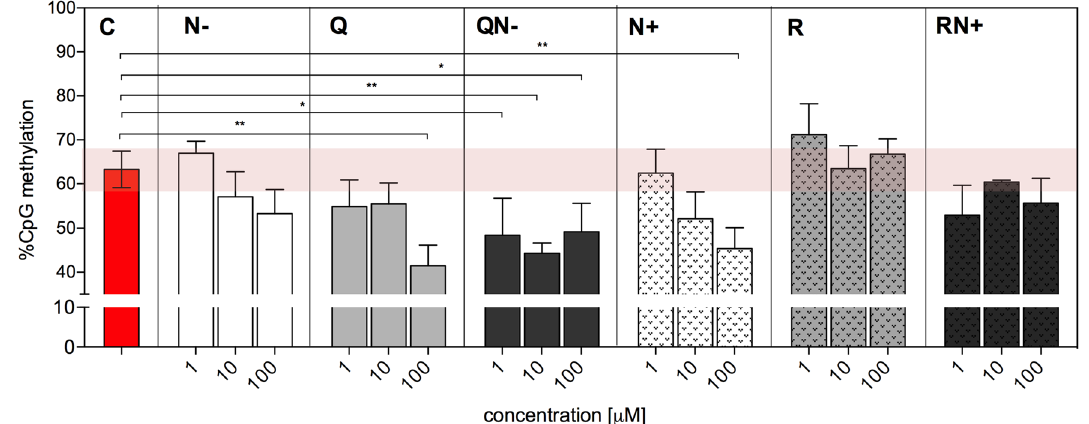
Figure 6. Global DNA methylation of HT29 cells exposed to flavonoids (1–100 μM) and their mixtures containing equal concentrations of each compound (1–100 μM) determined by the epigenetic version of the comet assay. The percentage of DNA in the tail in the case of MspI treatment represents all CCGG sites in cellular DNA, while HpaII is presumed to digest only non-methylated sequences. The global DNA methylation was calculated as described under Materials and Methods section. Control (C) refers to cells treated with solvent only. Results represent the means of three independent experiments. Significantly different values determined by one-way ANOVA with Dunnett’s test are marked as: * p ≤ 0.05, ** p ≤